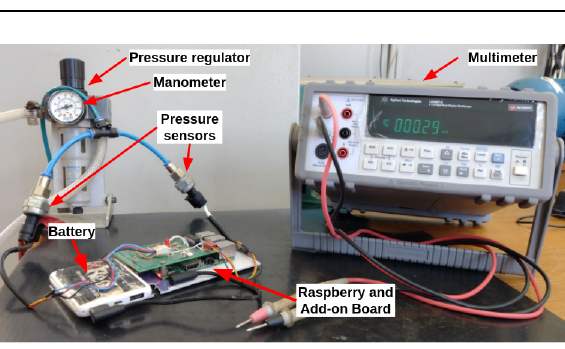
Figure 25. Devices used in the curve-fitting procedure.